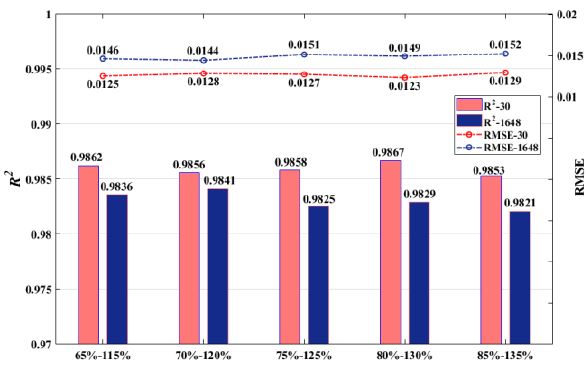
Figure 8. Tests for variation of peak/minimum load.